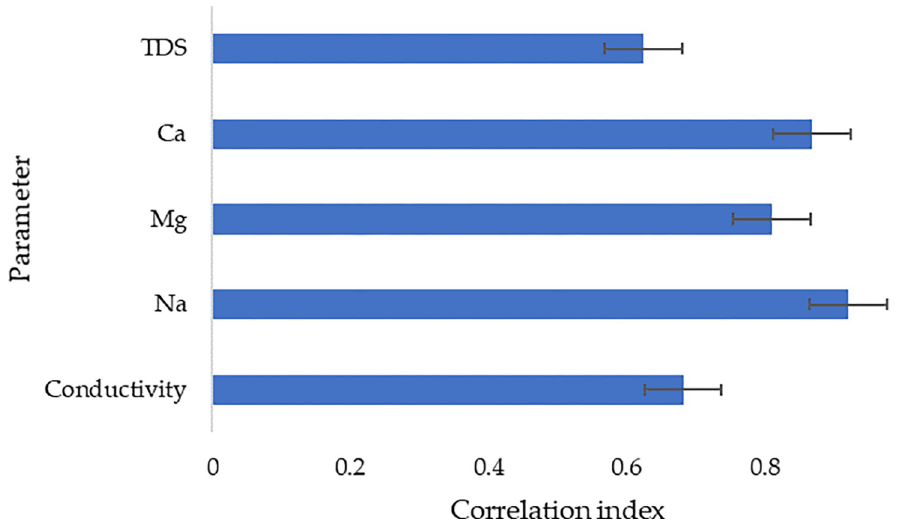
Fig 5. Correlation indices between pH and other water quality